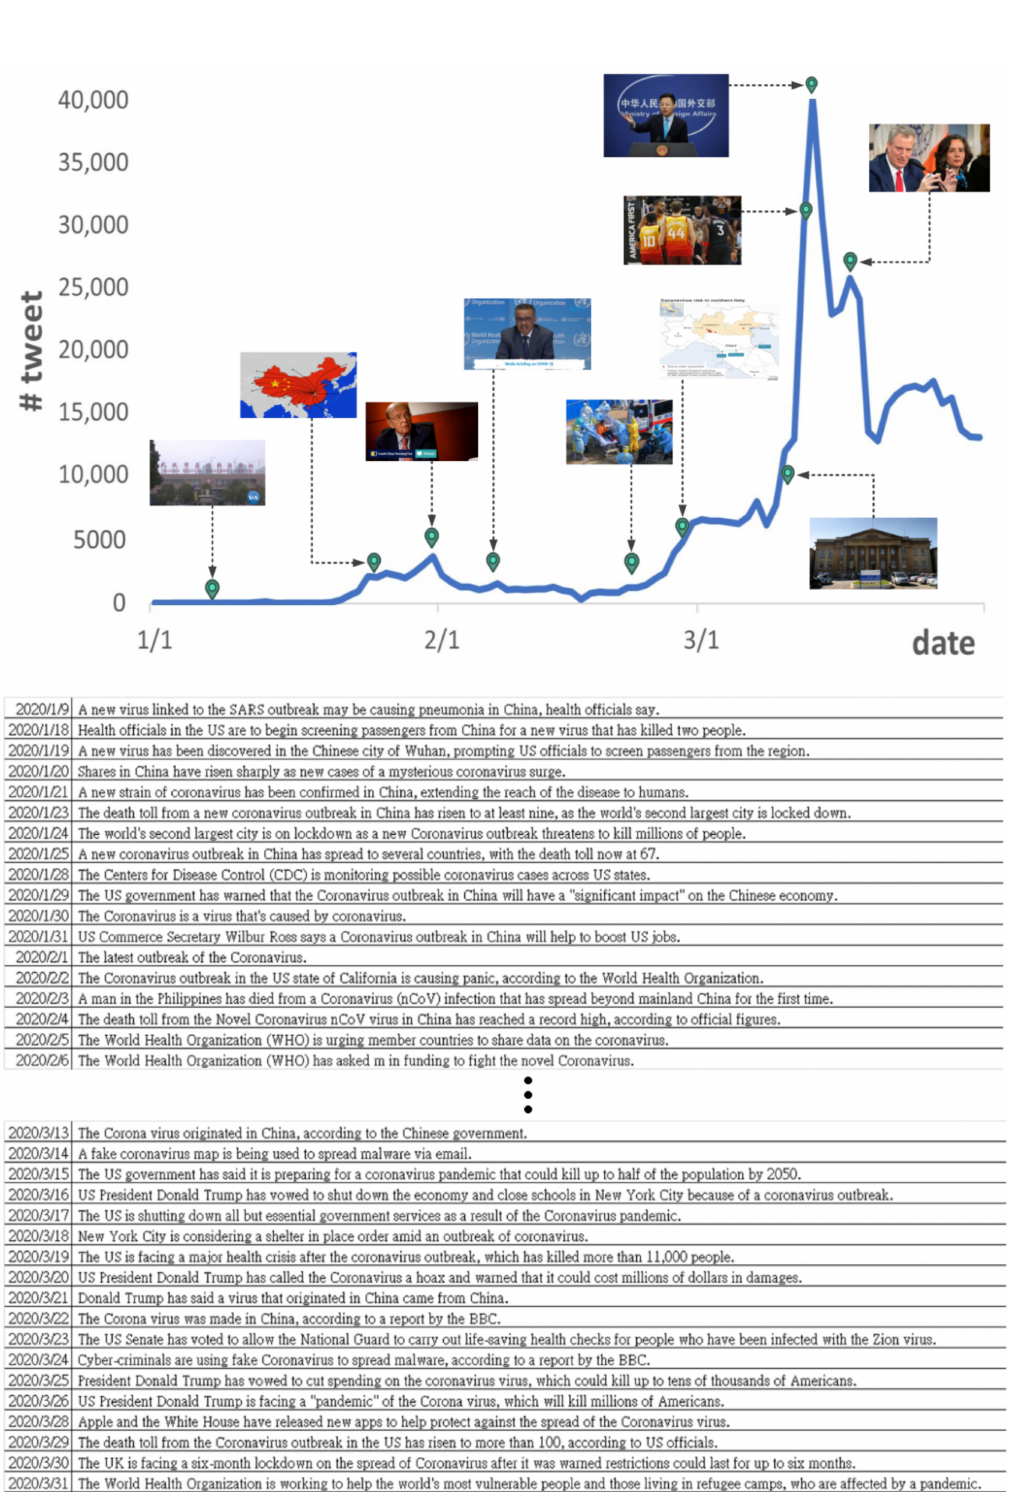
Figure 6. Generated storyline related to COVID-19 from January to March